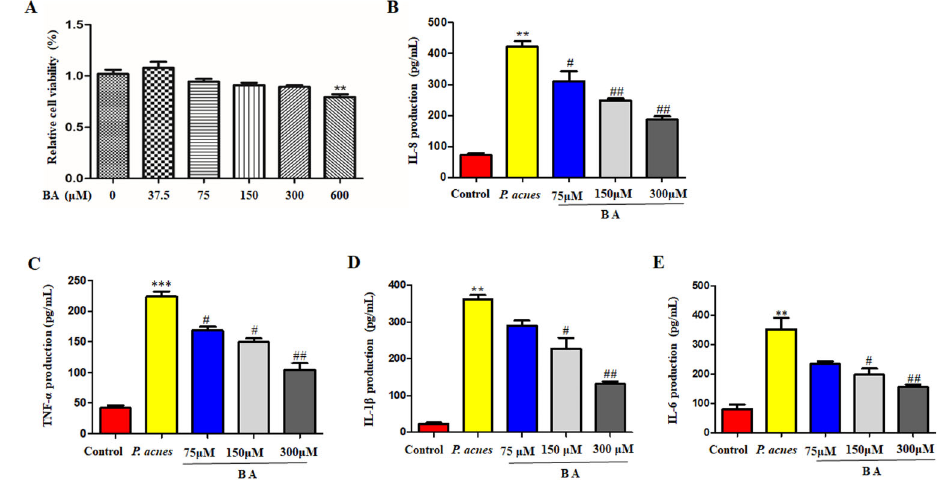
Figure 1. Effects of baicalin (BA) on P. acnes- induced cytokine production in THP-1 cells. A , Survival rate of THP-1 cells following treatment with BA at concentrations of 37.5, 75, 150, 300, and 600 m M for 24 h was evaluated using the CCK-8 kit. B - E , Levels of interleukin (IL)-8, tumor necrosis factor (TNF)- a , IL-1 b , and IL-6, in P. acnes -stimulated THP-1 cells quanti fi ed by ELISA. The data are reported as means ± SE from at least three independent experiments. **P o 0.01, ***P o 0.001 vs control; # P o 0.05, ## P o 0.01 vs P. acnes alone (ANOVA).